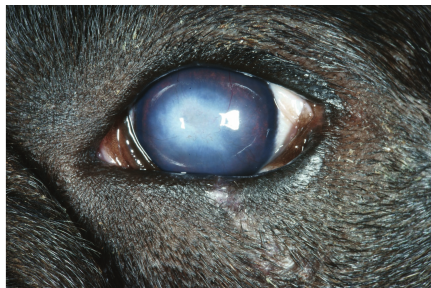
Figure 7: Case 2 appearance OS, 1 month after surgery. A discreet oblique scar is stillpresent on thelower eyelid. No sign of discomfort is